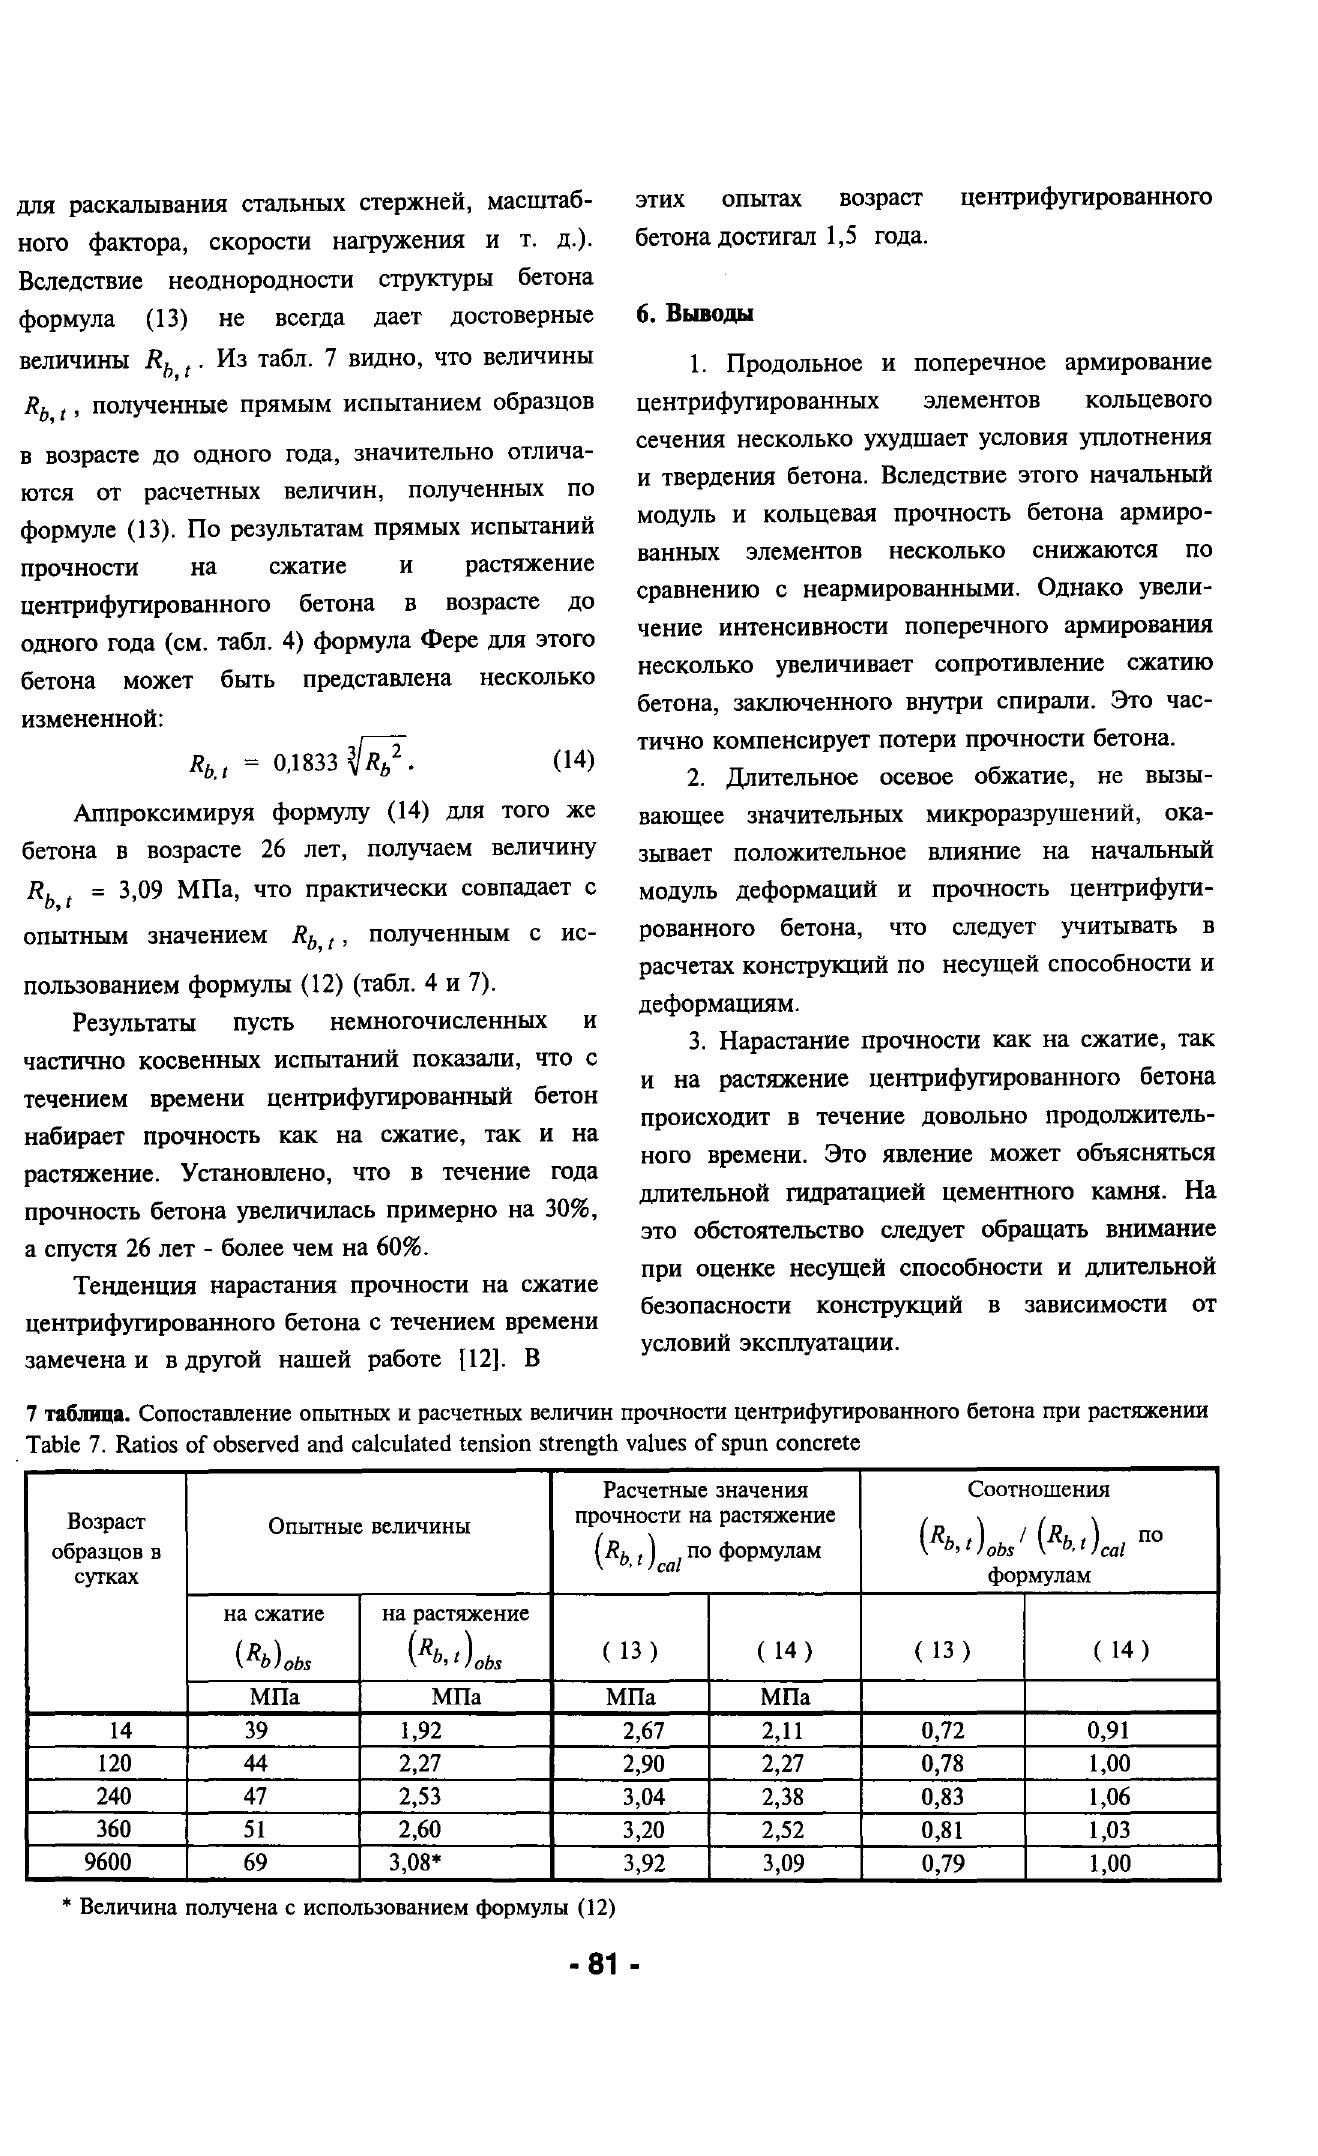
PacqeTHble JHaqeHHH